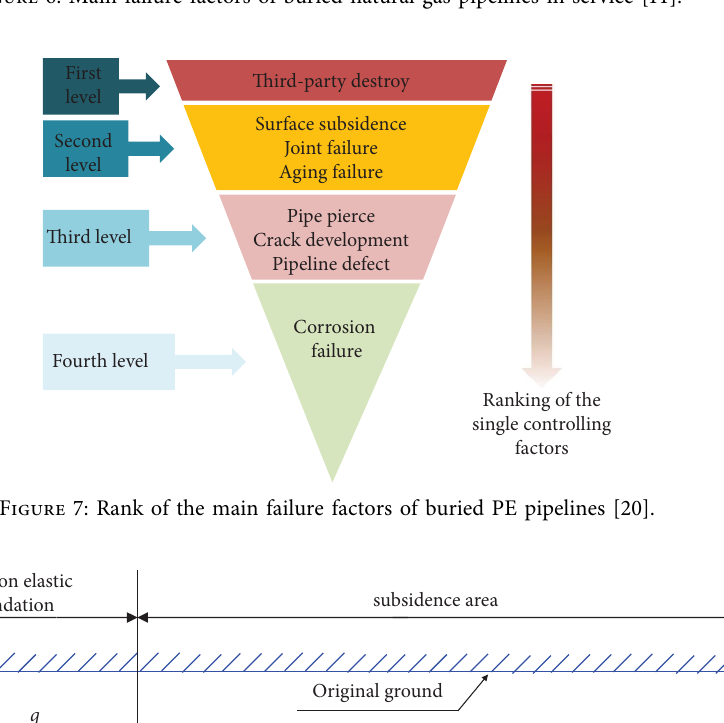
Figure 6: Main failure factors of buried natural gas pipelines in service [11].